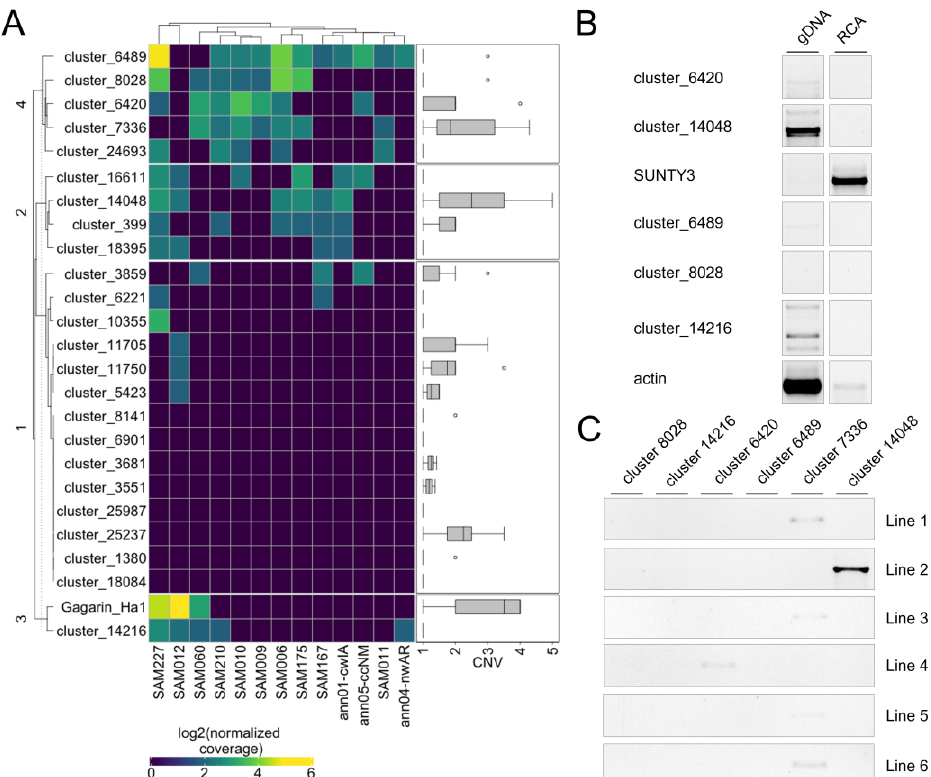
Figure 5. Transposition activity of full-length RTEs expressing LTR-RTE transcripts. ( A ) Heatmap shows the variability of normalized RTE coverage by short genomic reads in different sunflower accessions. The boxplots demonstrate the number of similar (>80% similarity and >80% coverage) RTE copies found in different sunflower genome assemblies normalized by the minimum number of copies among all assemblies. ( B ) EccDNA detection for six selected RTEs (PCR with actin primers is a control on linear DNA removal). ( C ) Inter-retrotransposon amplified polymorphism (IRAP) polymorphism for selected RTEs in six sunflower lines.